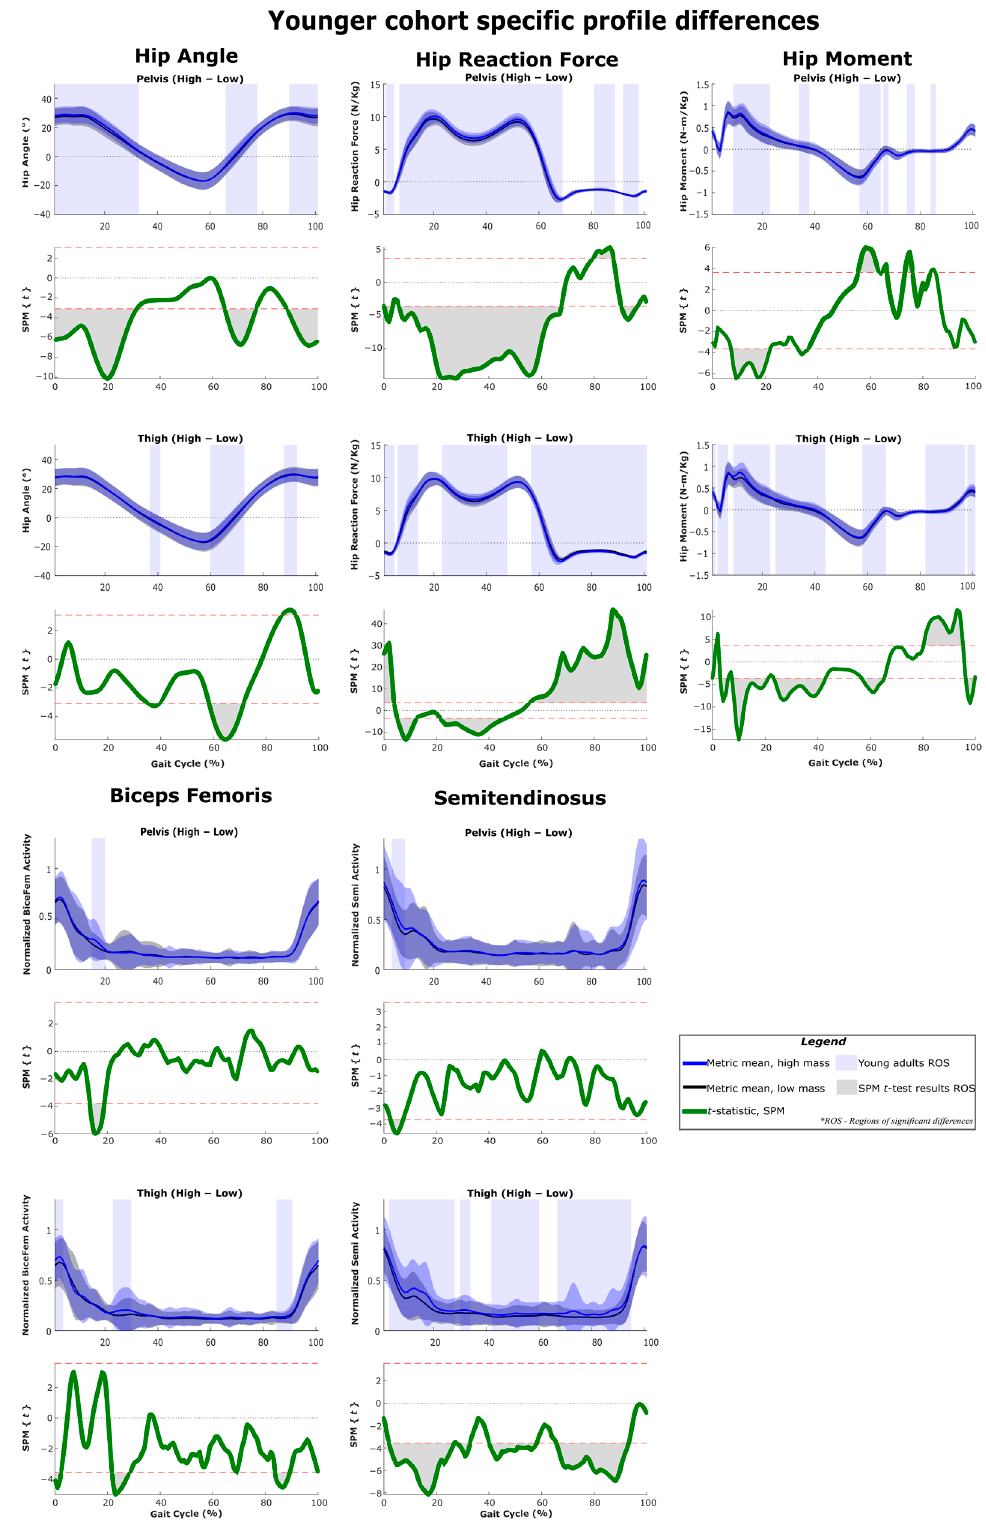
Figure 9. SPM t -test results and profile plots of the metrics, comparing low mass to high mass in the pelvis and thigh segments for participants in the younger cohort. Joint parameters are primarily related to the hip joint. The t -statistic is qualitatively identical to the effect size and can be used as an indicator of practical significance.